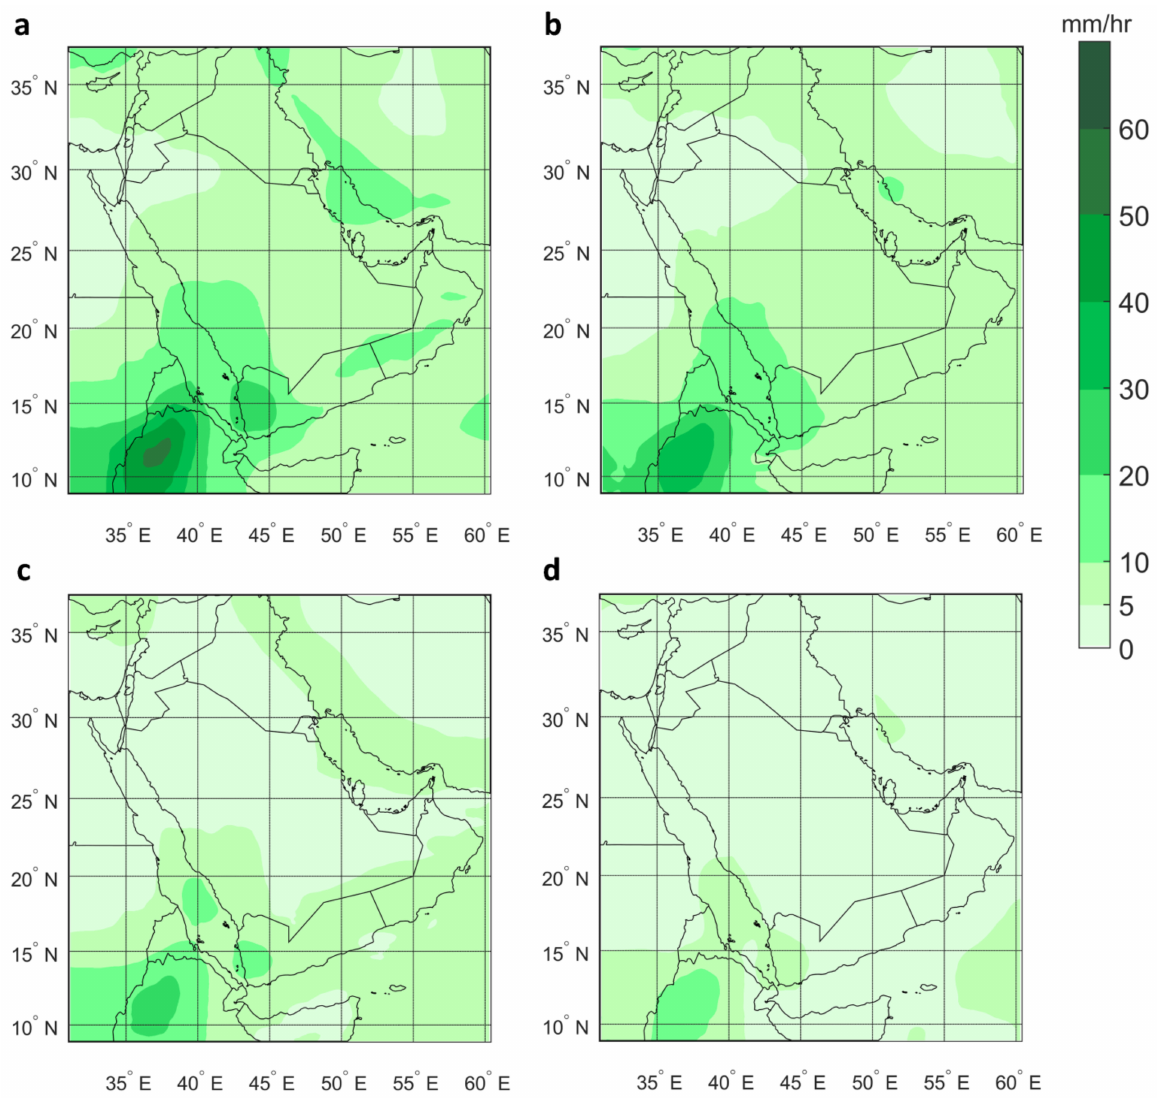
Figure A3. Average rainfall intensity (modeled) for durations of 3, 6, 12 and 24 hours ( a – d , respectively) and a 100-year return